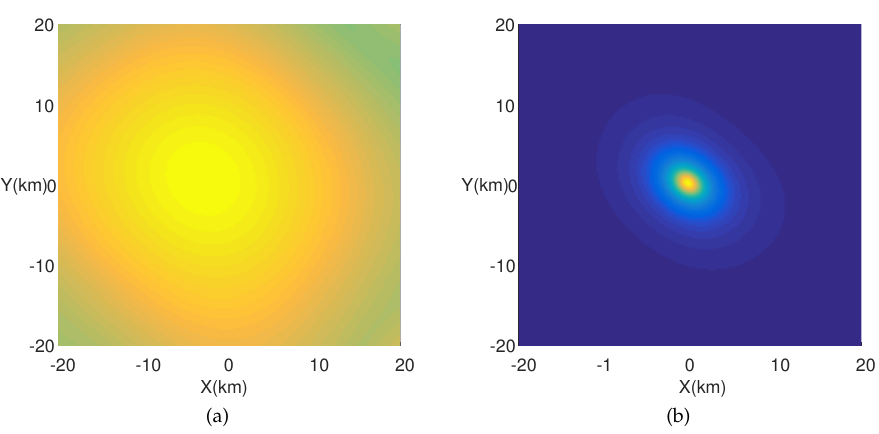
Figure 4. Spatial spectrum of Signal Subspace Projection (SSP)-MUSIC and Noise Subspace Projection (NSP)-MUSIC in a single path scenario. ( a ) SSP-MUSIC ( b ) NSP-MUSIC.